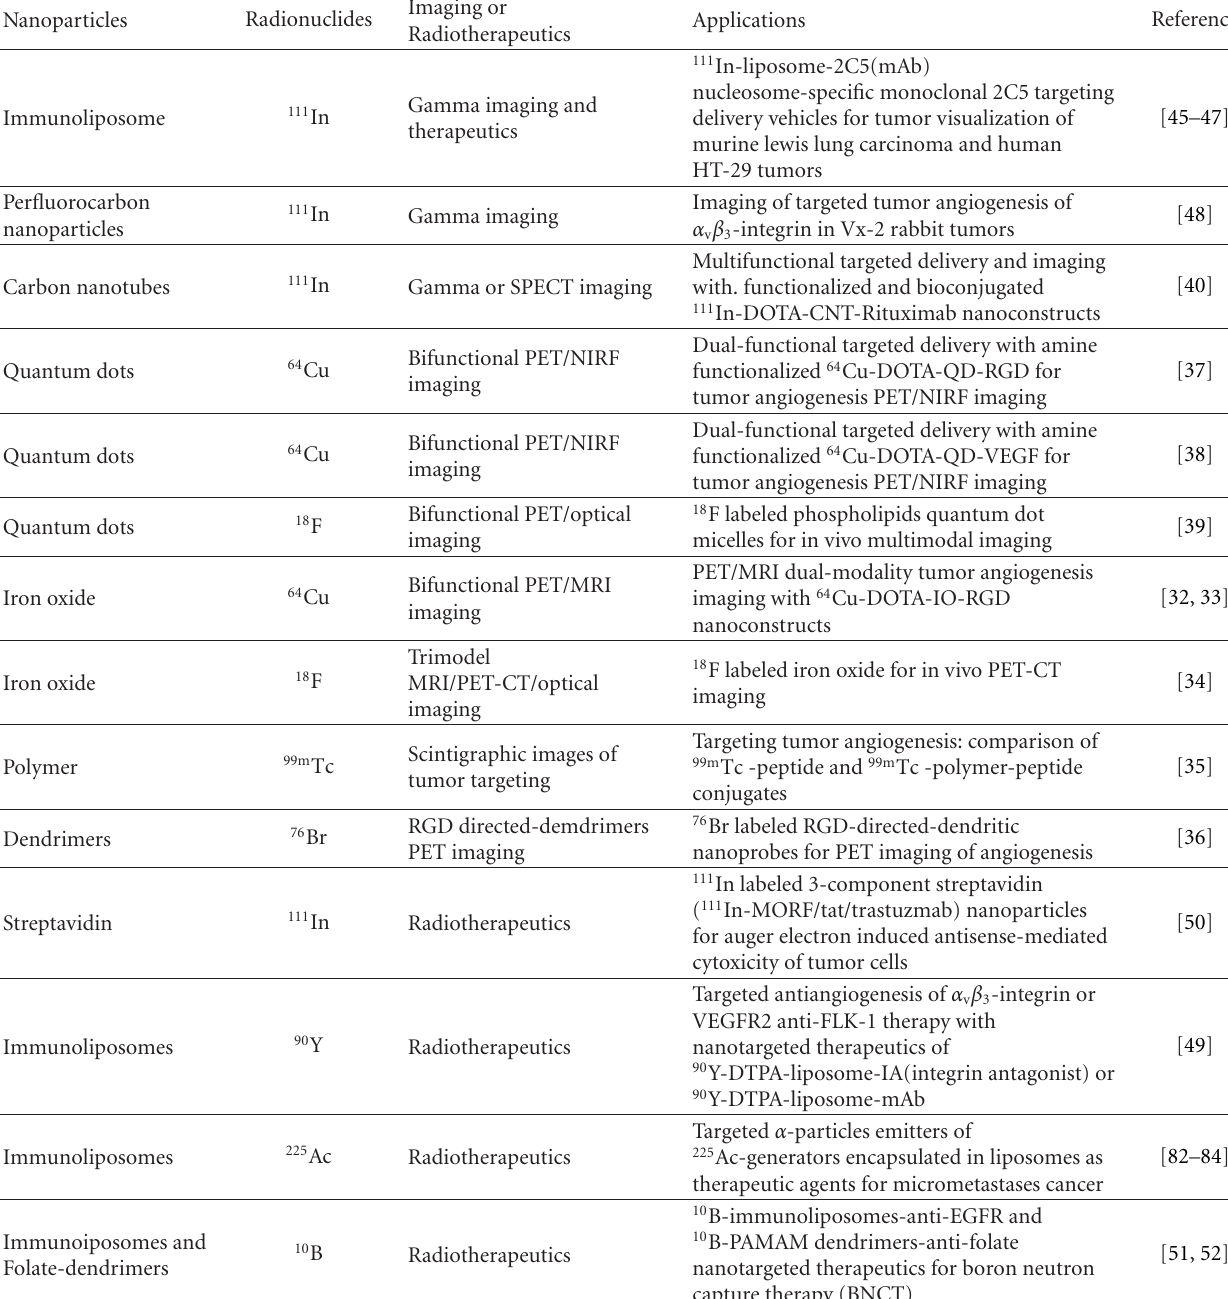
Table 5: Selected actively nanotargeted tumor nuclear imaging and radiotherapeutic applications.